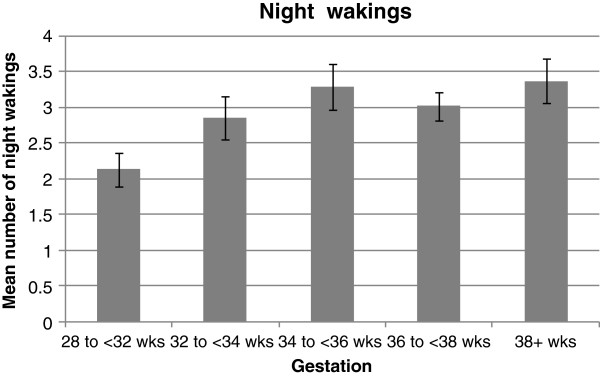
Mean number of times waking at night at each gestational age. Error bars denote standard error of mean.